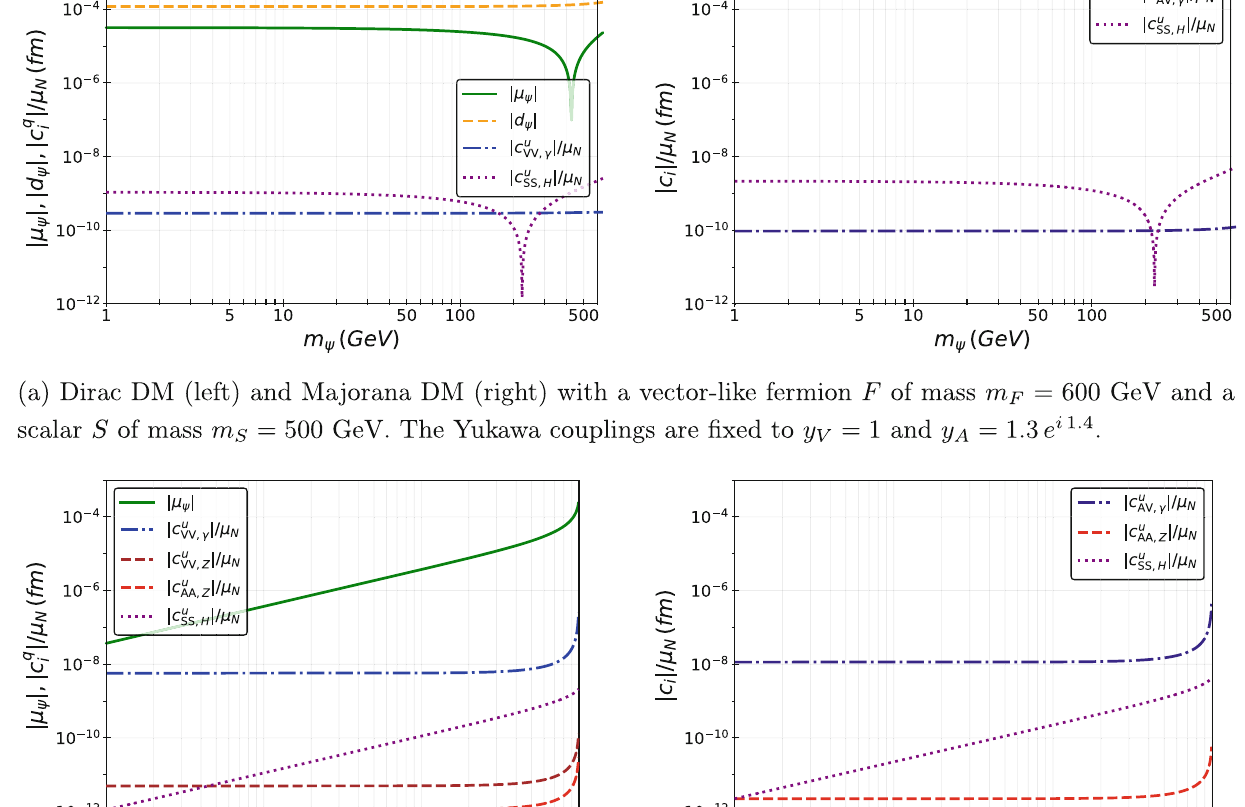
nuclear magneton μ N = e /( 2 m p ) . The photon penguin contribution c u depends on the transferred momentum q for light SM leptons: VV ,γ We choose a recoil energy E R = 8 . 59 keV for 132 Xe which results in 54 |(cid:12) q | 2 = 2 . 11 × 10 − 3 GeV